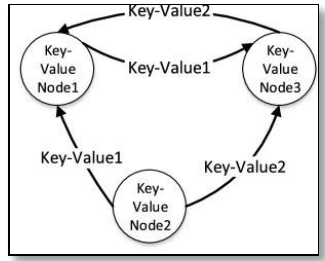
Figure 4 . Graph Store Database (Grolinger et al.,